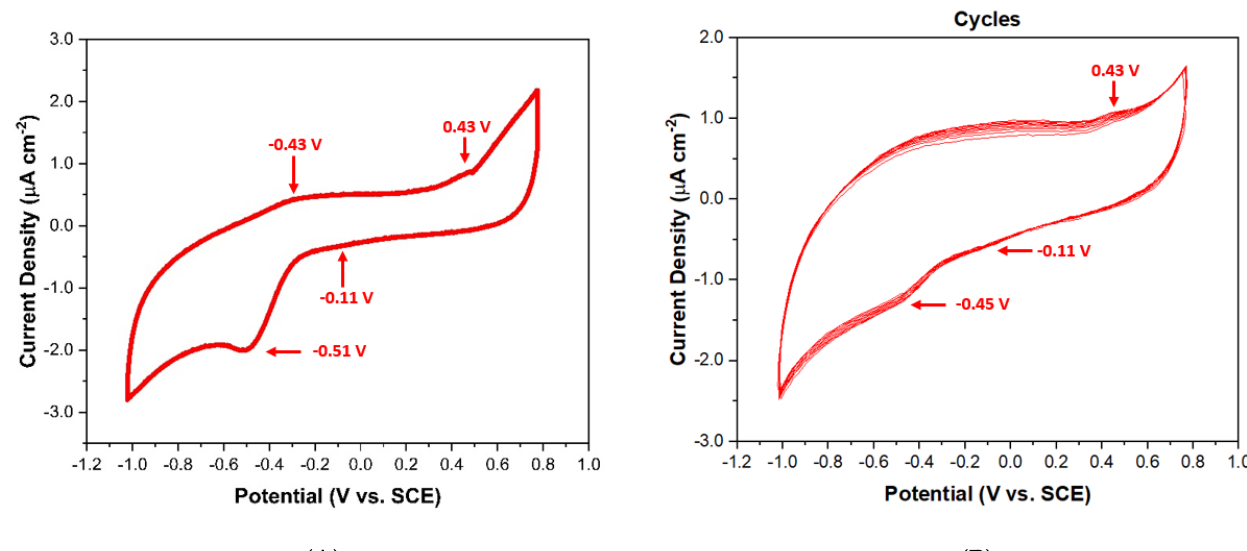
Figure 10. Cyclic voltammograms of 10 µg/mL of 813-CDs ( A ) at 25 mV/s scan rate ( B ) in repeat cycles recorded in H 2 O using 0.1 M NaCl as supporting electrolyte, glassy carbon (GC) electrode as working electrode, Ag/AgCl as reference electrode, and a Pt wire as a counter electrode.